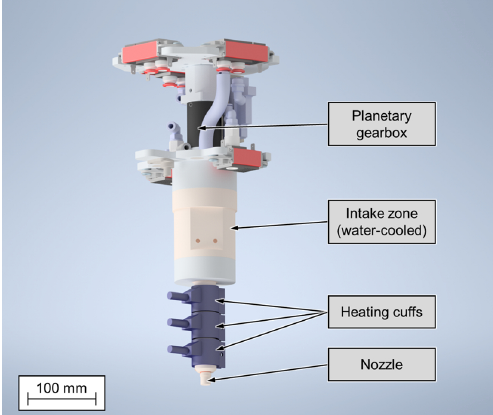
Figure 1. Screw-based extruder for processing thermoplastic pellets in additive